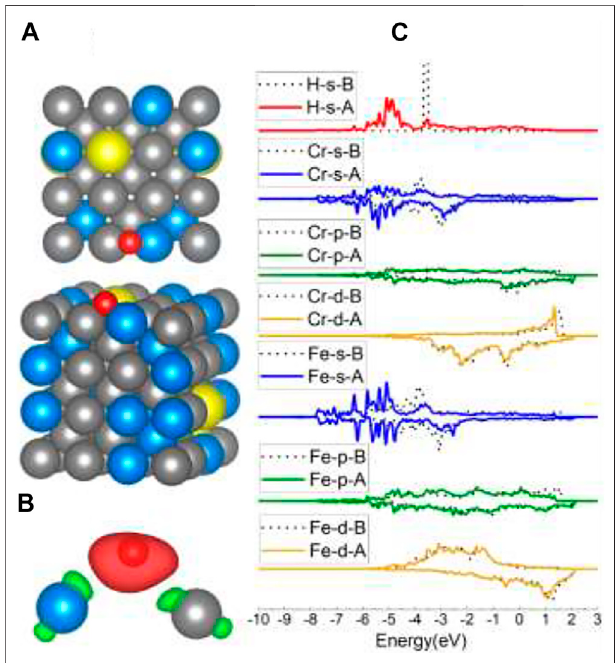
FIGURE 6 | The optimized structure, charge density difference, and DOS of the Fe – Cr bridge site after the hydrogen atom is adsorbed on the FeCrAl (100) surface: (A) top and side view of the H-slab structure, (B) charge densitydifference(theisosurfaceofchargedifferenceis0.007electrons/ Bohr 3 ),red colorrepresentschargeaccumulation,andgreencolorrepresents charge depletion, and (C) DOS before and after H atom adsorption, the black dotted lines represent s / p / d orbitals before H atom adsorption, and B/A represents before and after,